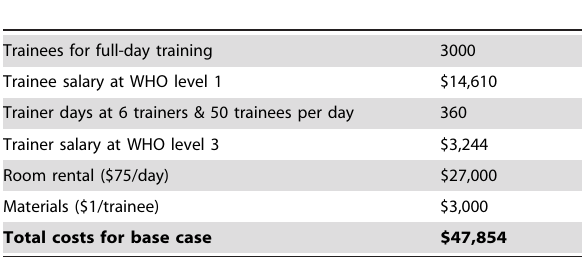
Table 5. Annual cost of training 3000 lay first-responders (Base case).